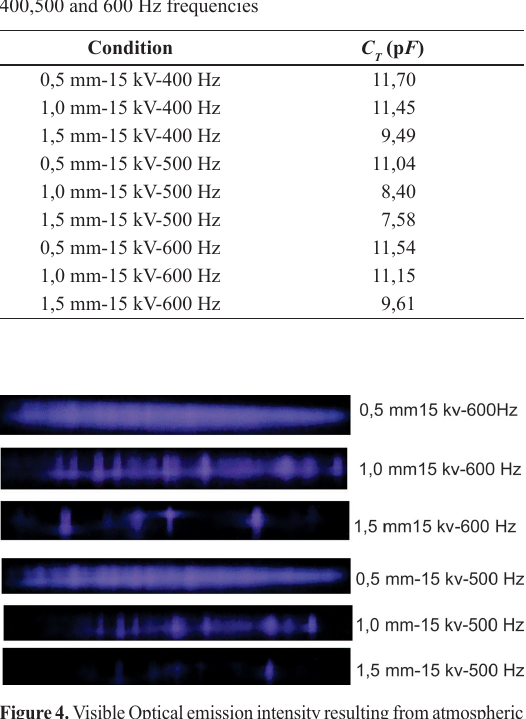
Table 2. Electrical energy consumption per cycle ( E Distance (mm)